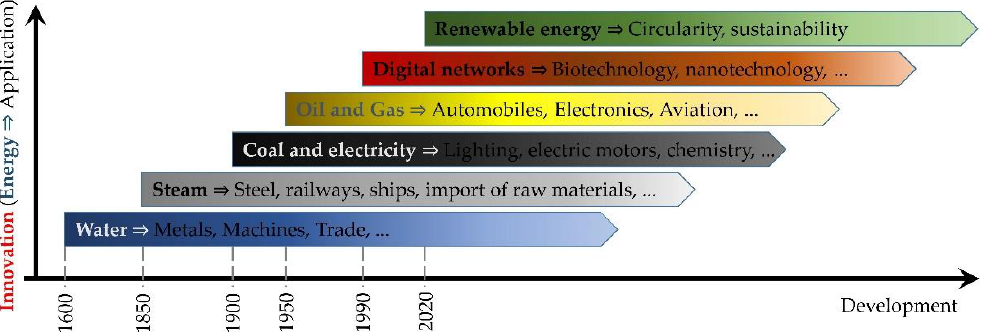
Figure 1. Innovative structure, waves of innovation, years 1600–2020. Source: authors according to [12,15].